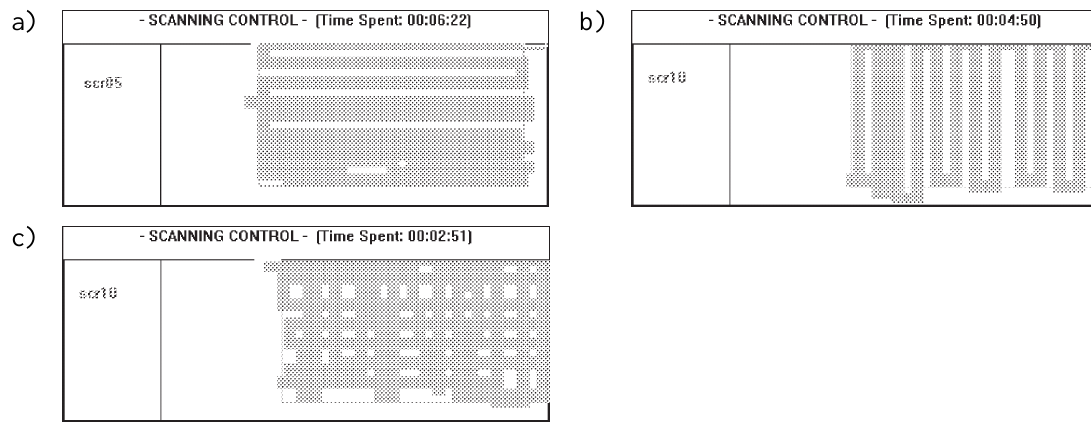
Fig. 1. (a) Horizontal screening. (b) Vertical (battlement) screening. (c) Combined